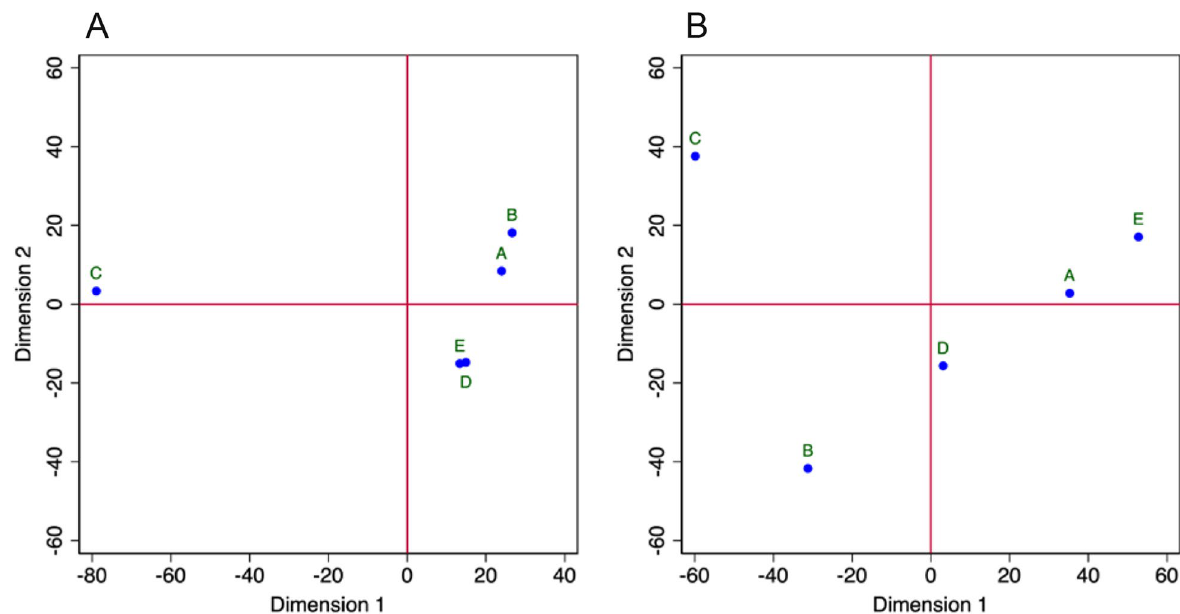
Fig. 3 A Results of the MDS of the data collected by metabarcoding, computed using only OTUs with frequencies of reads > 1%. B Results of the MDS of the data collected by serial dilution. A‑E indicate the cellars as described in Table 1. Samples that are geometrically close to each other in the graph are colonised by similar fungal